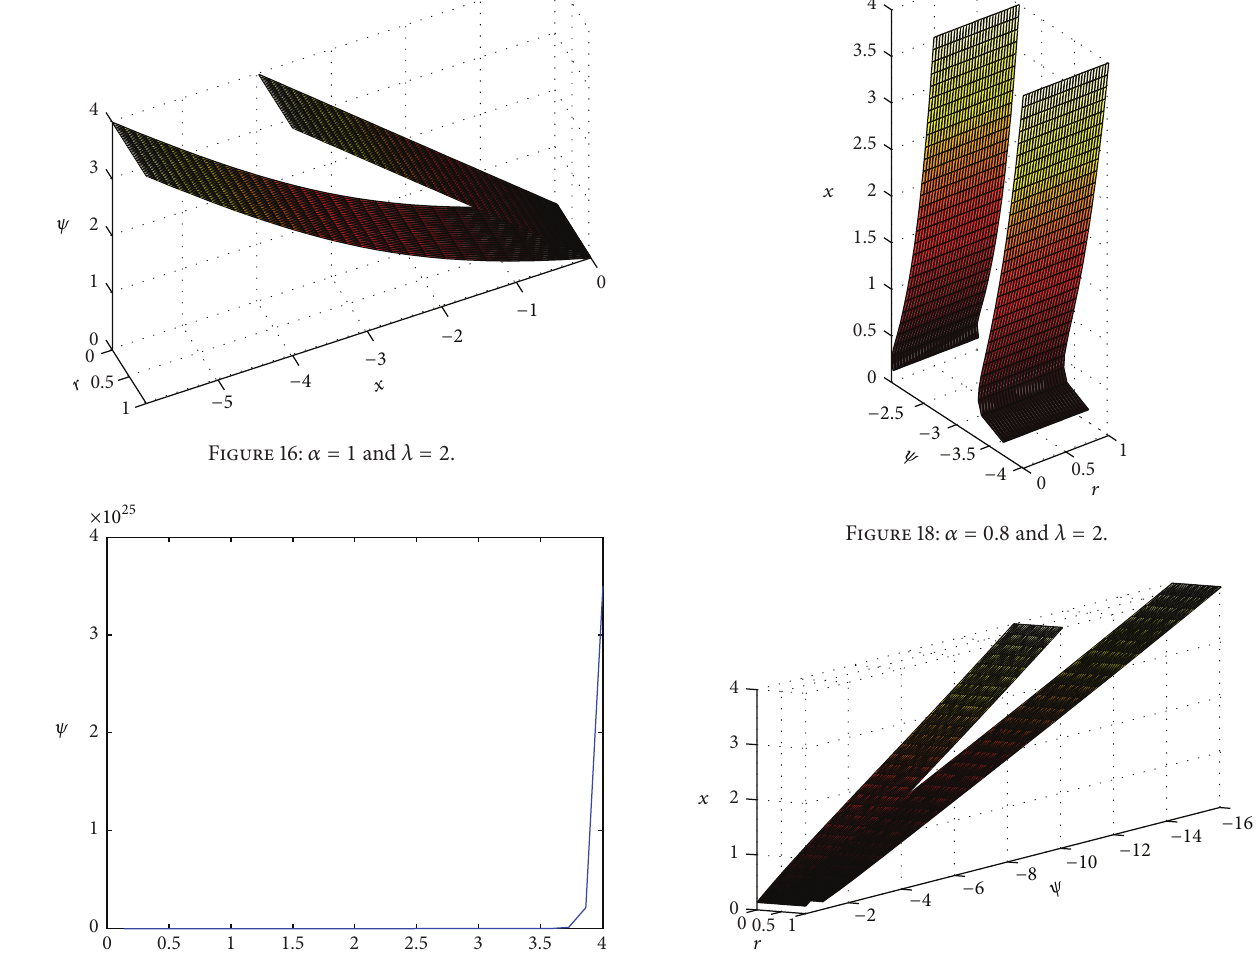
Figure 19: 𝛼 = 0.3 and 𝜆 = 2